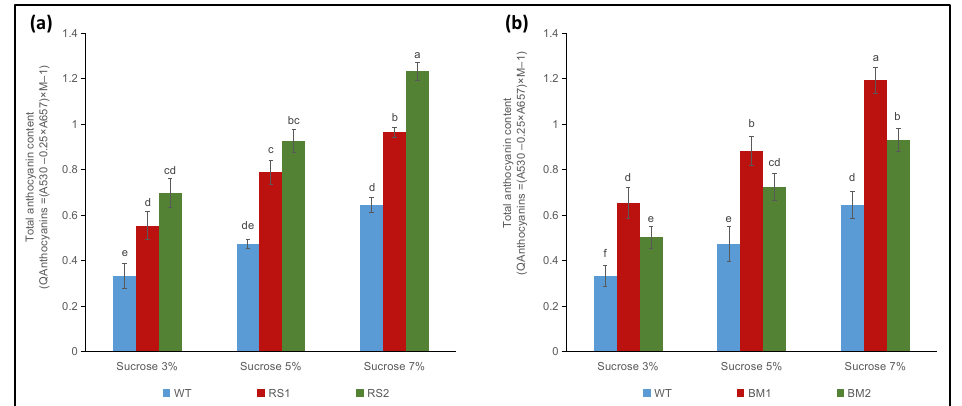
Figure 1. Comparison of total anthocyanin content in transgenic ( a ) RsMYB1 and ( b ) B-Peru + mPAP1 and wild type (WT) plants of Torenia “Kauai Rose” in response to different sucrose concentrations. Data are presented as the means of three replicates. Error bars indicate standard error. Groups annotated with the same letter are not significantly different by Duncan Multiple Range Test (DMRT, p < 0.05).